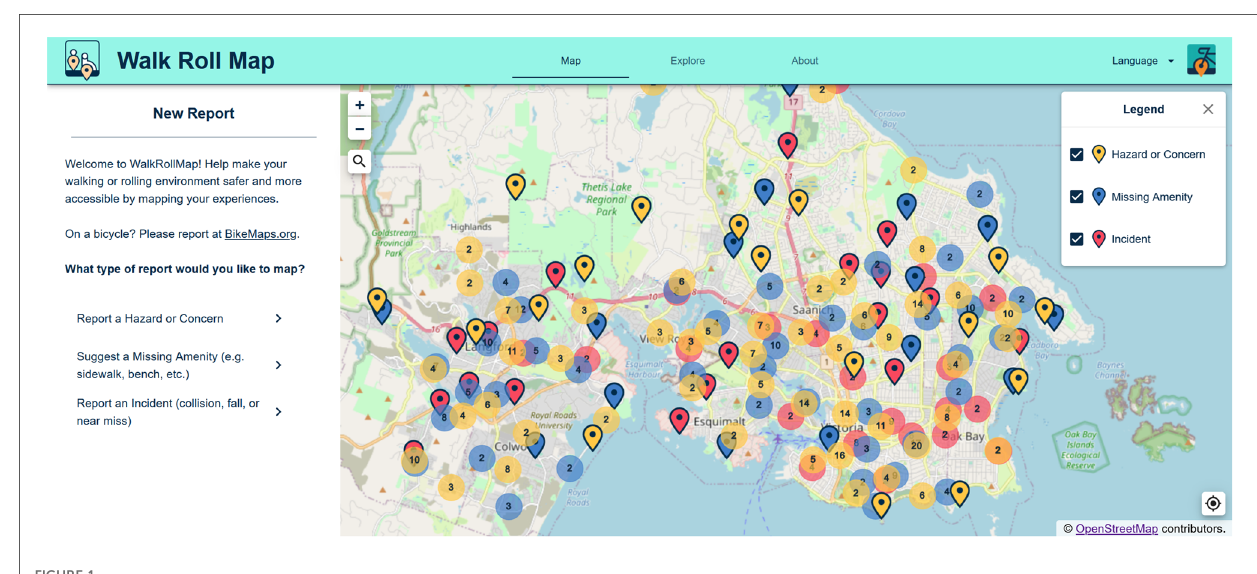
FIGURE 1 Landing page for